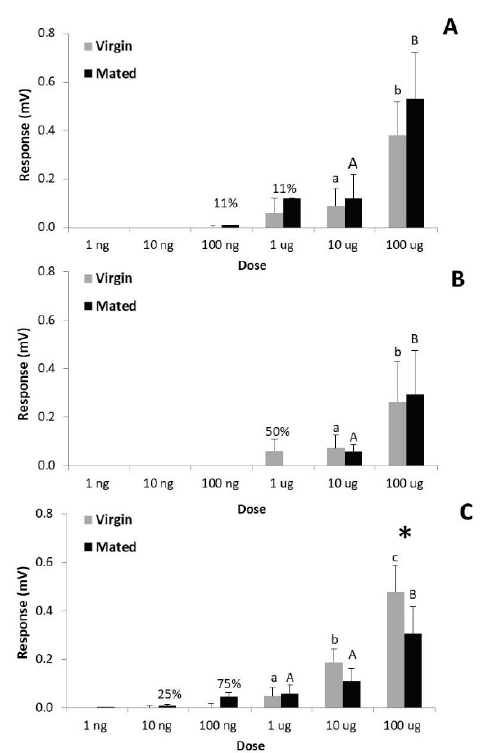
Figure 5. Mean EAG response ( + SE) of female antennae (N = 8–9) of T. absoluta to the synthetic pheromone compounds TDTA ( A ) and TDDA ( B ), and to the binary mixture ( C ). Numbers above bars represent percentage of antennae that responded to the specific dose but the corresponding EAG values were not taken into consideration for statistical analysis. No percentage on bars indicates that all antennae responded. Bars with different letters in the same mating status (in lower case virgin and in capital mated females) represent significant differences among doses (Tukey post hoc test, p < 0.05). The asterisk on the pair of columns indicates significant difference between mating status (Student’s T -test, p < 0.05).